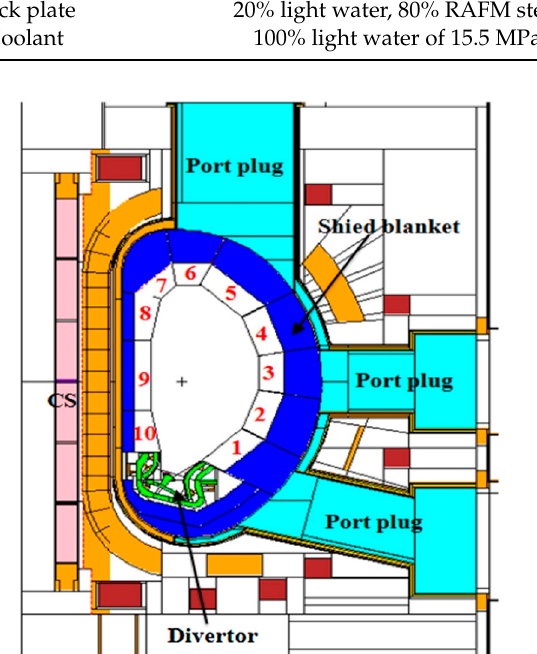
Figure 11. Vertical cross section of the CFETR with the WCCB neutronics model.